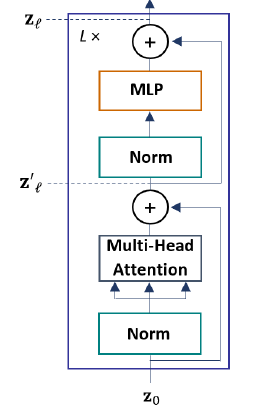
Figure 4. The architecture of the Transformer encoder.